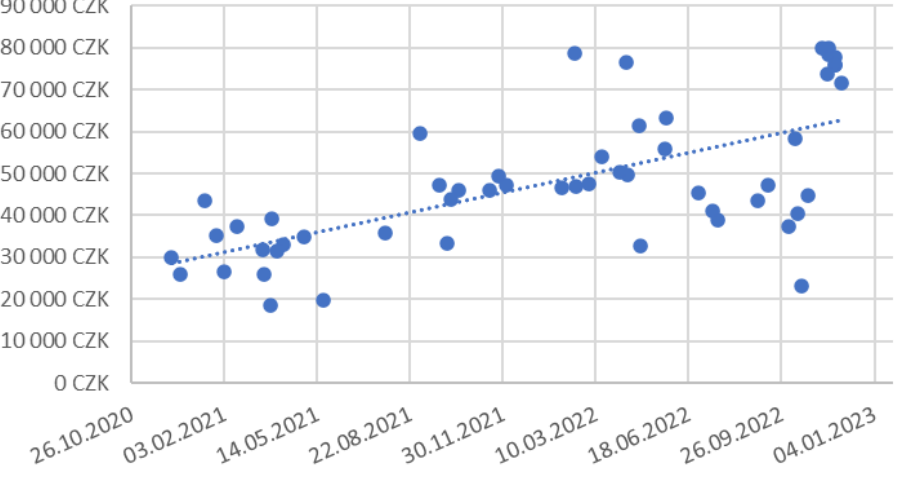
Figure 4: Development of real estate purchase prices (source: authors with use of [2]) The linear regression function has a R 2 reliability value of 0.434, i.e. 43.4%. This is a higher